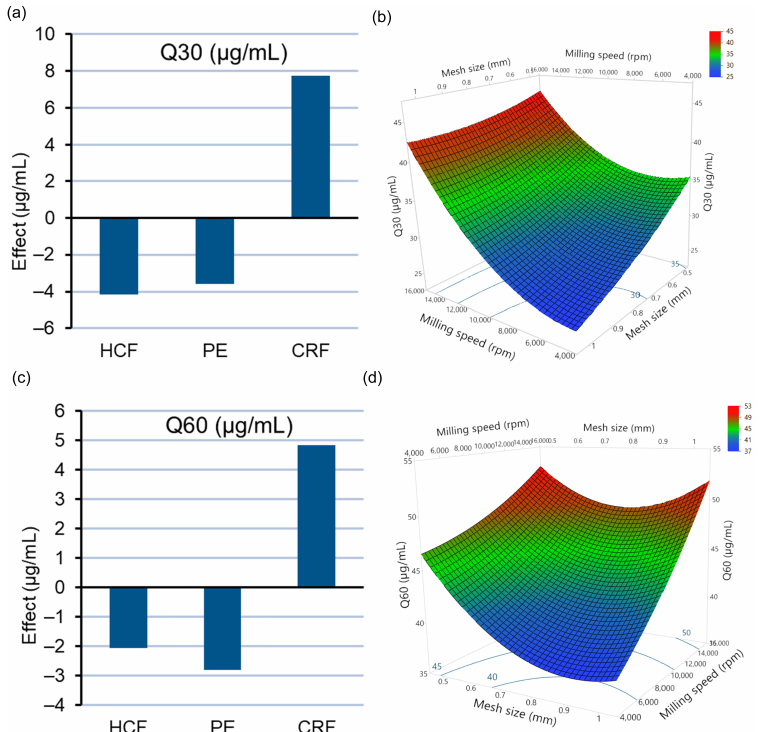
Figure 9. ( a ) Plot depicting the effect of type of feedstock on Q30 ( µ g/mL). ( b ) Response surface plot depicting the effects of milling speed and mesh size on Q30 ( µ g/mL). ( c ) Plot depicting the effect of type of feedstock on Q60 ( µ g/mL). ( d ) Response surface plot depicting the effects of milling speed and mesh size on Q60 ( µ